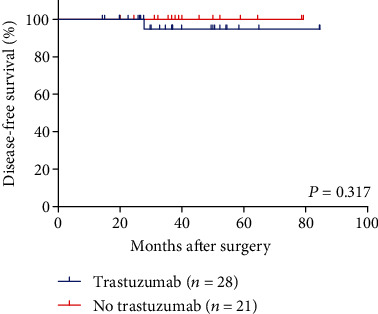
Association of trastuzumab use with DFS in pCR patients.